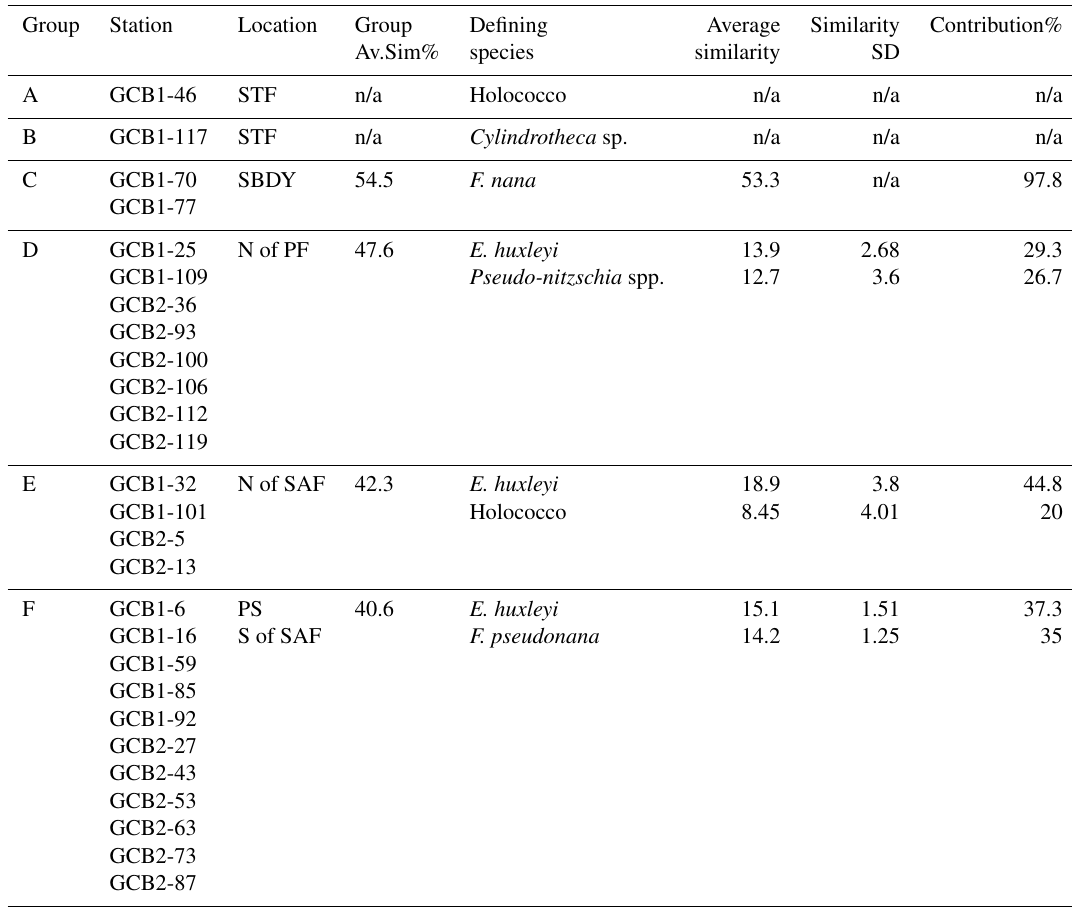
Table 4. Phytoplankton assemblage groups identified using the SIMPROF routine at p < 0 . 05 in the GCB (see also Fig. 3) from the South Atlantic (GCB1) and the southern Indian (GCB2) oceans. Location is indicated as in Fig. 2. Group average similarity (Group Av.Sim%) defines the percentage of similarity of the community structure in all the stations within each group. The defining species contributing > 50% to the species similarity for each group as identified through the SIMPER routine are presented alongside the average similarity for each species in each group (Average similarity); higher “Similarity SD” indicates more consistent contribution to similarity within the group. The percentage of contribution per species to the group similarity (Contribution%) was also calculated. Group averages not calculable (n/a) for single station groups A and